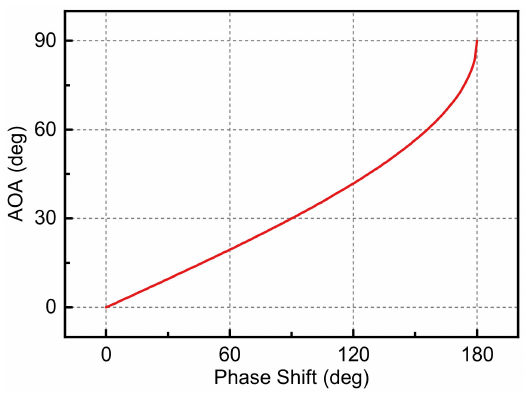
Figure 6. AOA versus the echo signal phase shift from 0 ◦ to 180 ◦